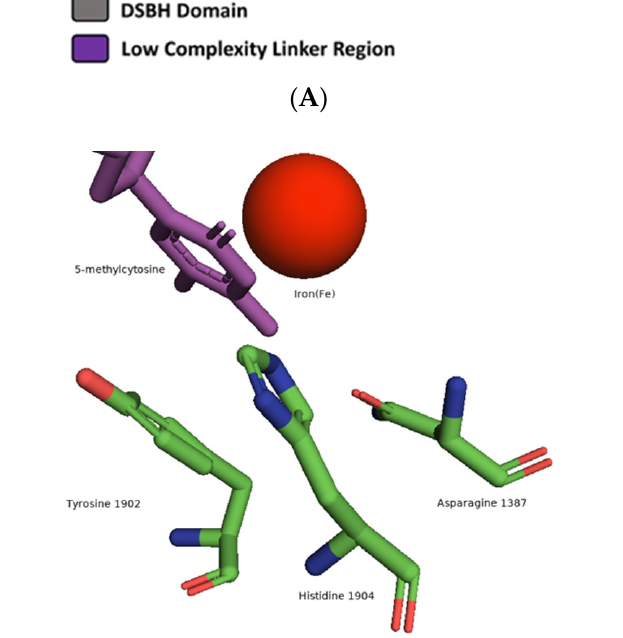
Figure 4. ( A ) Domain architecture of Human TET1, TET2, TET3. ( B ) Amino acid residues reside in close proximity to, and interact with the flipped out modified cytosine base in TET2 (PDB ID- 4NM6).